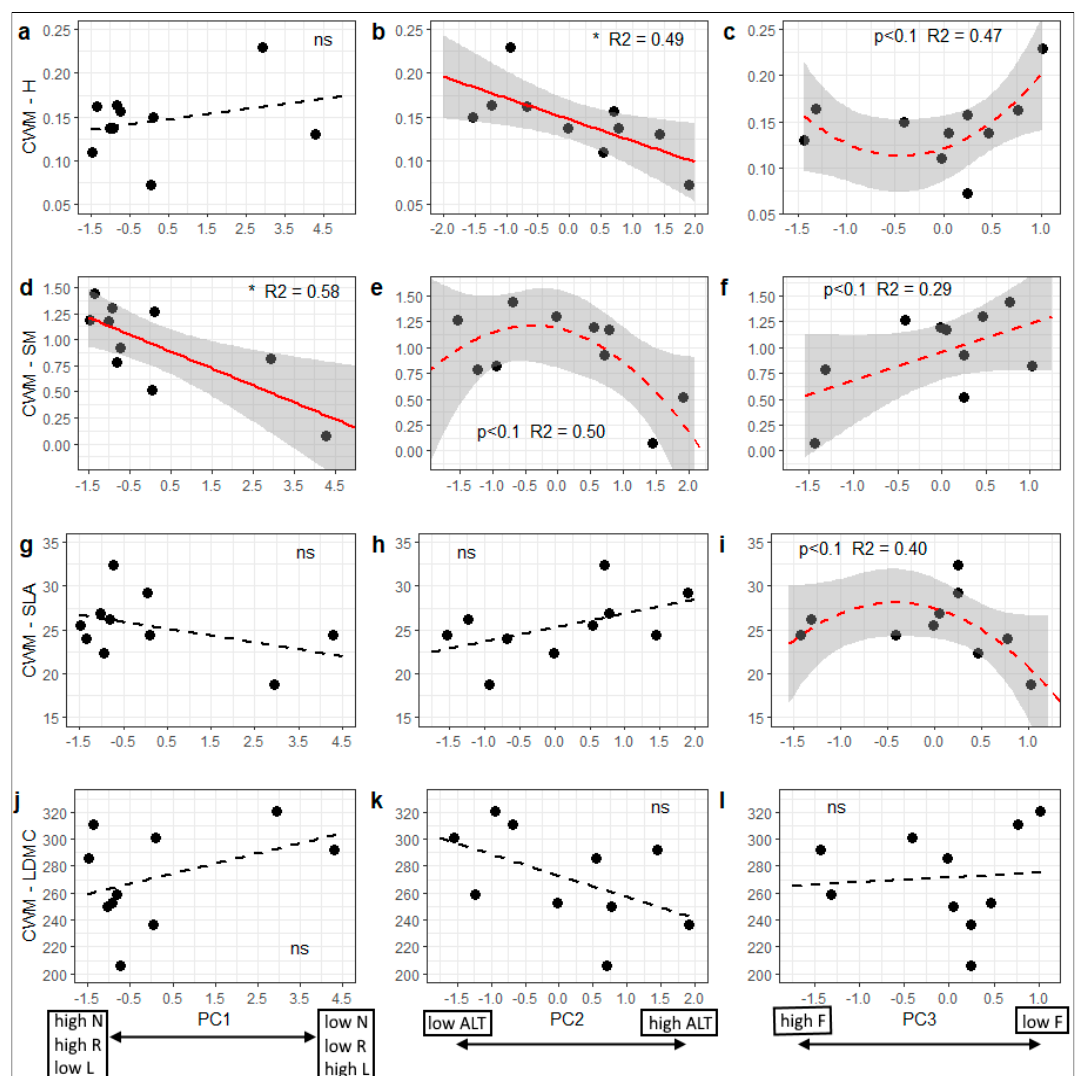
Figure 3. Relationship between the community-weighted means (CWM) of four functional traits (height—H, seed mass—SM, specific leaf area—SLA, leaf dry matter content - LDMC) and three environmental gradients associated with: PC1 = nutrient availability (N), soil pH (R) and light availability (L); PC2 = altitude (ALT); PC3 = soil moisture (F). Significant regressions are indicated with solid red lines and grey ribbons (95% confidence intervals), whereas dashed red lines indicate marginally significant results ( p < 0.1). Each data point ( n = 10) represents average site-level CWMs, averaged across large plots (10 × 10 m). Statistics for regression analyses are reported (* p < 0.05, ns – not significant ( p > 0.05), R 2 – explained variance).